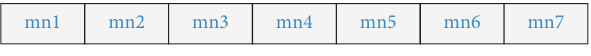
Figure 2: Schematic diagram of high-level chromosomes